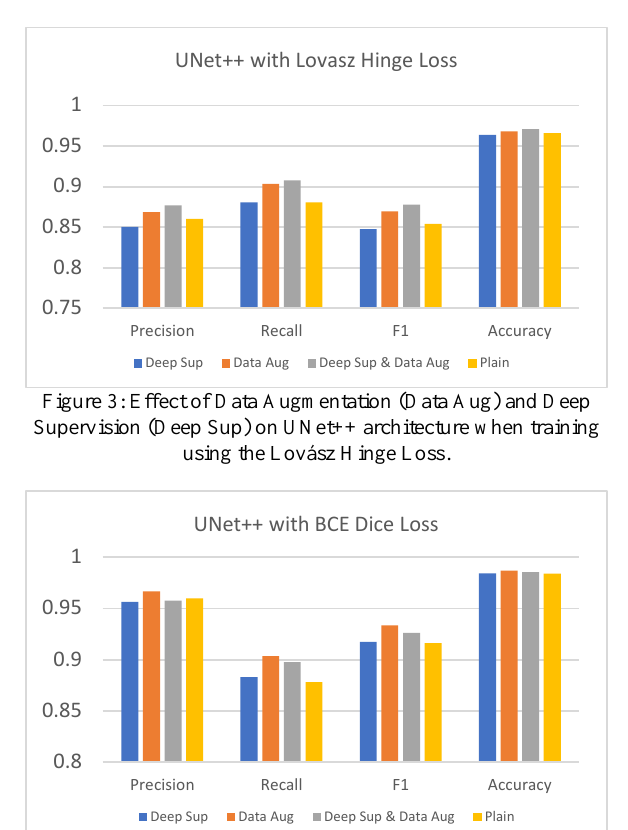
Figure 7: Comparison of the effects of different architectures and different loss functions.